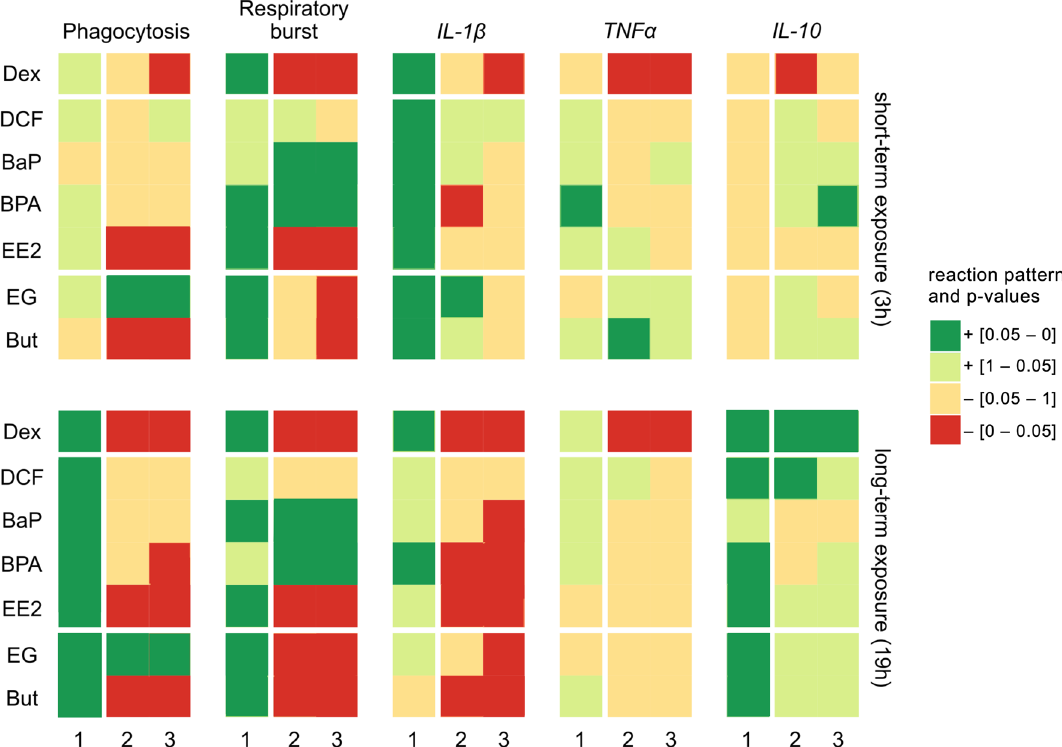
Figure 3. Overview of the in vitro immuno-assay results. Depictured are the results for the comparison of the LPS-stimulated control to the non-stimulated control (column 1 of each immune parameter) and the results for the comparison of the highest applied chemical concentration without (column 2) and with LPS stimulation (column 3) compared to the control without or with LPS stimulation, respectively. Data is displayed for short- (top) and long-term (bottom) chemical exposure separately. Colors represent the p values of the comparisons with underlying decreasing effects in red and for increasing effects in green in relation to the corresponding control. If the p value was below 0.05, statistical significance was accepted. The reference compound dexamethasone (Dex), the other immunotoxicants ( DCF diclofenac, BaP benzo(a)pyrene, BPA bisphenol A and EE2 ethinylestradiol) and the non-immunotoxicants ( EG ethylene glycol and But butanol) were clustered with white dividing lines. A detailed, color-blind-, print-friendly version can be found in Supplementary Material